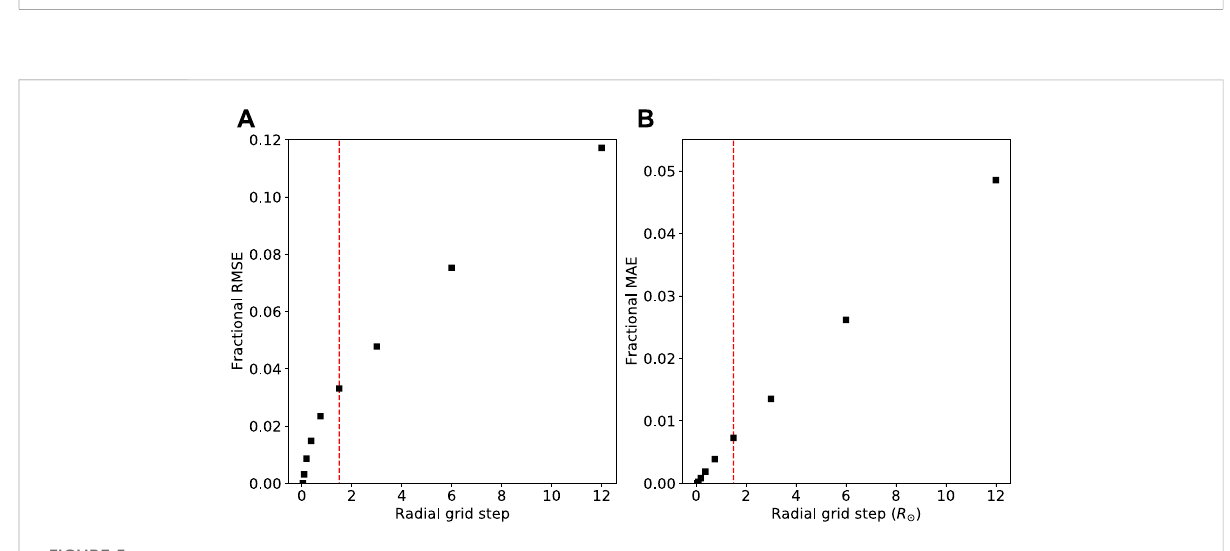
(Top) Hovmöller (distance-time) diagrams of the HUXt solar wind speed solutions for the set of different radial grid steps, with radial grid step decreasing from right to left. (Bottom) Hovmöller diagrams of the fractional error in the HUXt solution at a given radial grid step relative the HUXt solution at the fi nest radial grid step of dr = 0.047 R ⊙